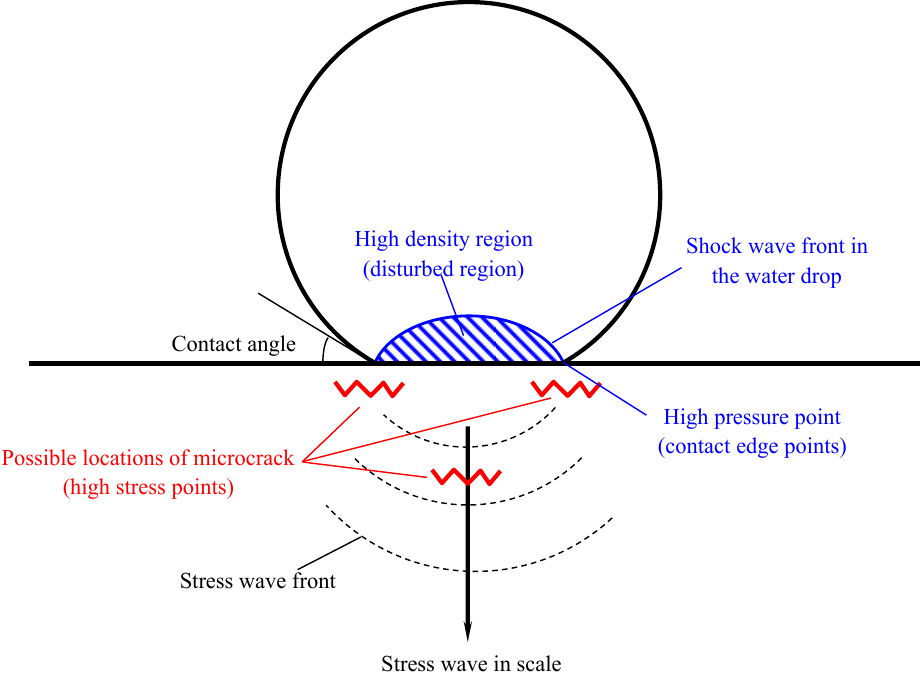
Figure 1. The schematic diagram of the droplet impacting the